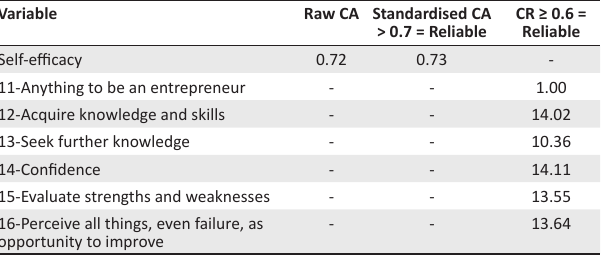
TABLE 2: Cronbach alpha and composite reliability results.